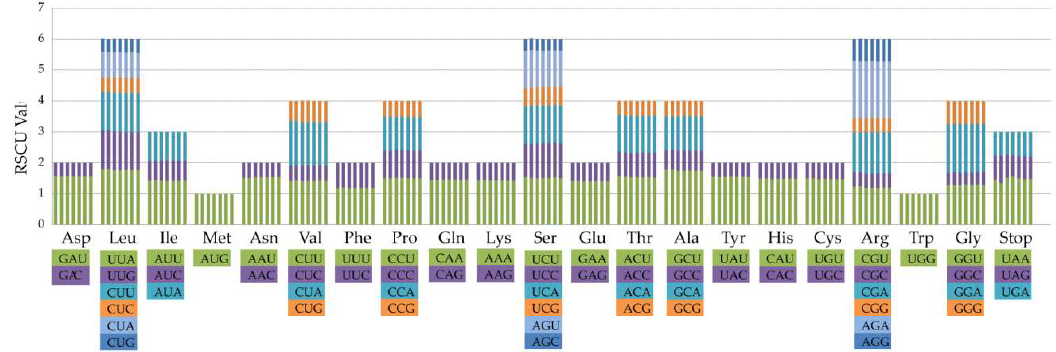
Figure 4. Codon content of 20 amino acid and stop codons in all protein-coding genes of the seven cp genomes. The histogram from the left-hand side of each amino acid shows codon usage within Aristolochia (From left to right: A. tagala , A. tubiflora , A. moupinensis , A. kunmingensis , A. kaempferi , A. macrophylla , and A. mollissima ).